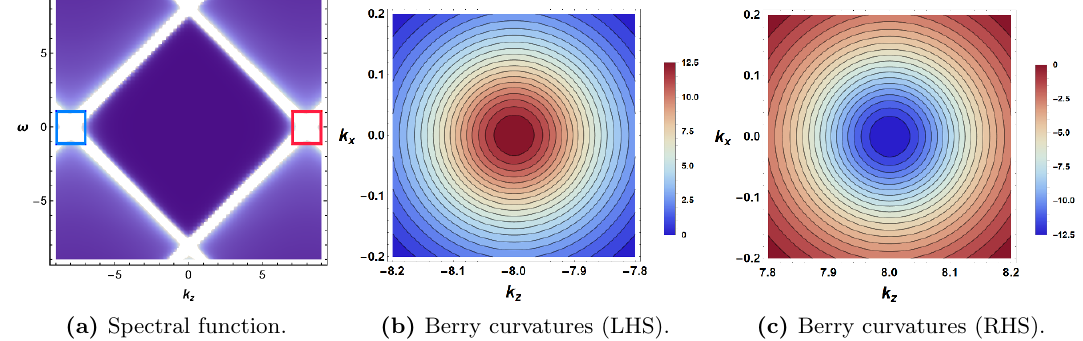
Figure 7. (a) Spectral function without scalar interaction. We used ( b; M ) = (8 ; 0) and T = 2 =(cid:25) . k x = k y = 0 (cid:12)xed. (b),(c): Berry curvatures near k z = (cid:0) 8 and 8 at the plane ( k y = (cid:0) 0 : 2 , ! = 0), where topological numbers are still 1 and -1